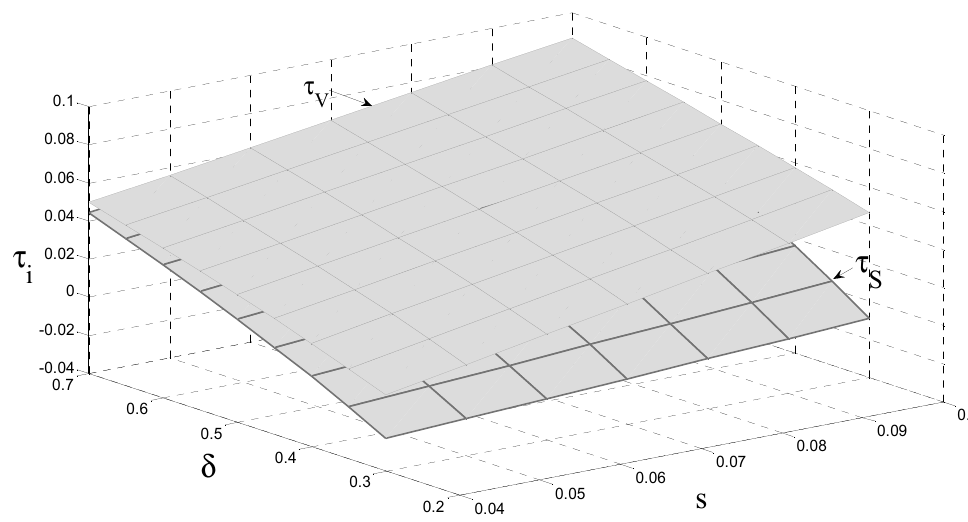
Figure 3. The impact of the carbon tax and consumer preference on the collection rate of EOL.